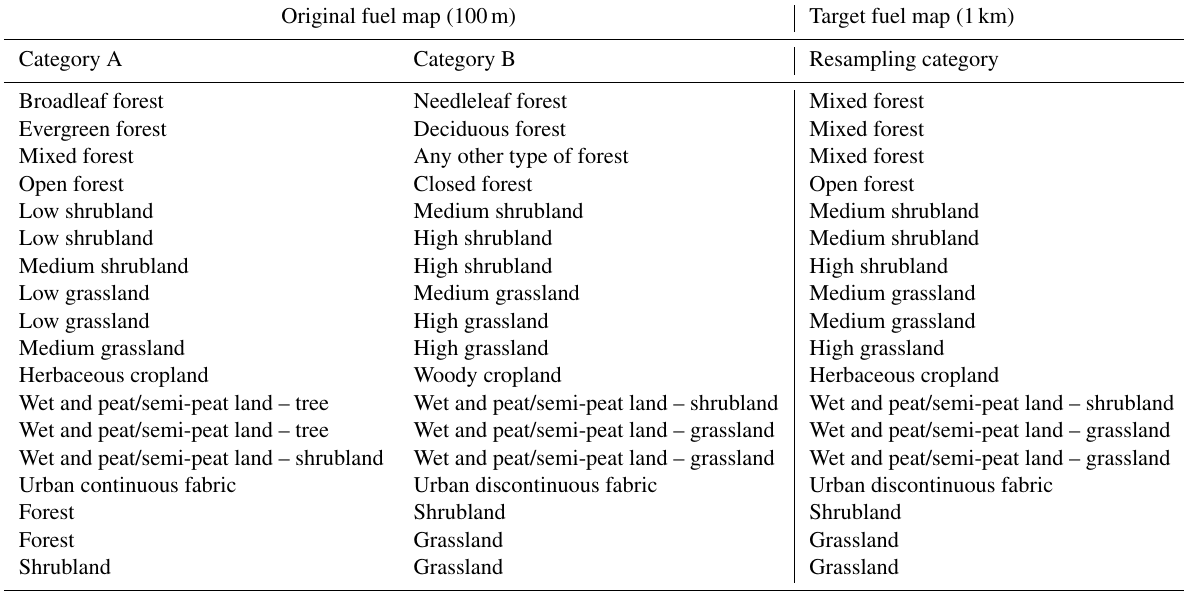
Table 2. Combination of fuel types used to resample the 100m resolution European fuel map to the target 1km spatial